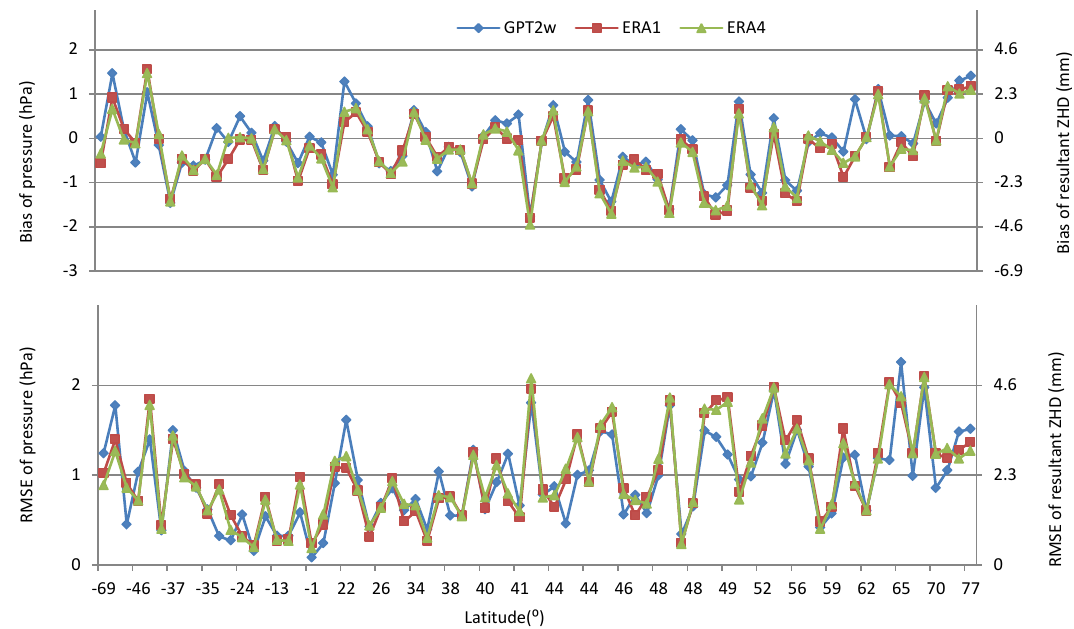
Figure 7. Bias of P_GPT2w and pressure derived from the seasonal models (annual and semiannual cycles) estimated from P_ERA1 and P_ERA4 time series (seasonal model derived from surface observations was used as a reference).